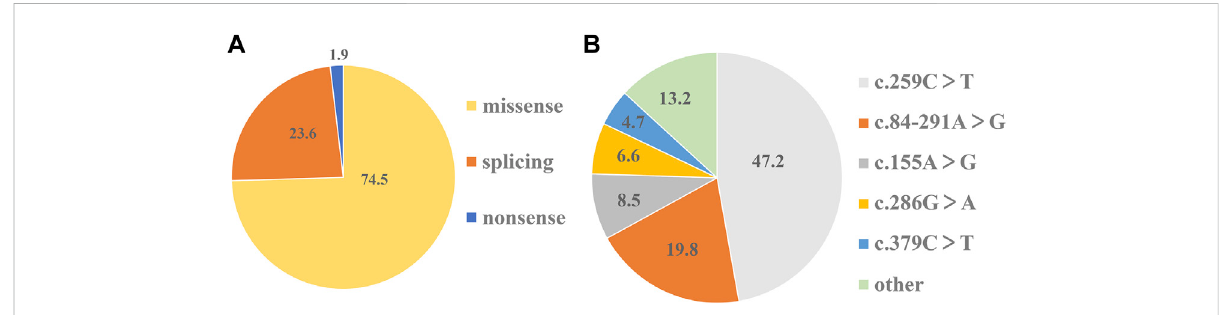
FIGURE 2 Shares of mutation types and prevalent frequencies of detected variants. (A) The percentage of three types of variants in 106 detected variants respectively. (B) The percentage of each variant in 106 detected variants respectively.